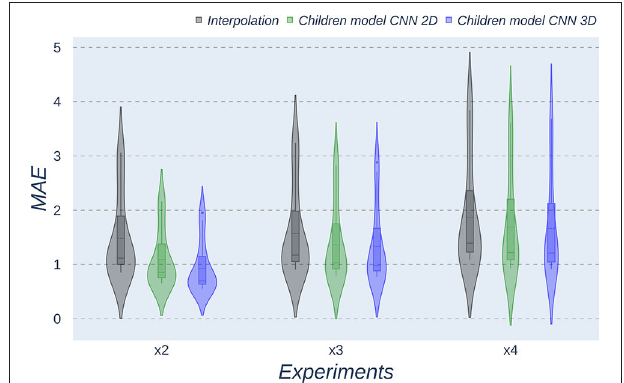
FIGURE 8 | Violin plots for MAE metric comparing the different methods at the distinct scaling factors. Each violin plot corresponds to one specific experiment, and it is calculated from dysplasic patients.